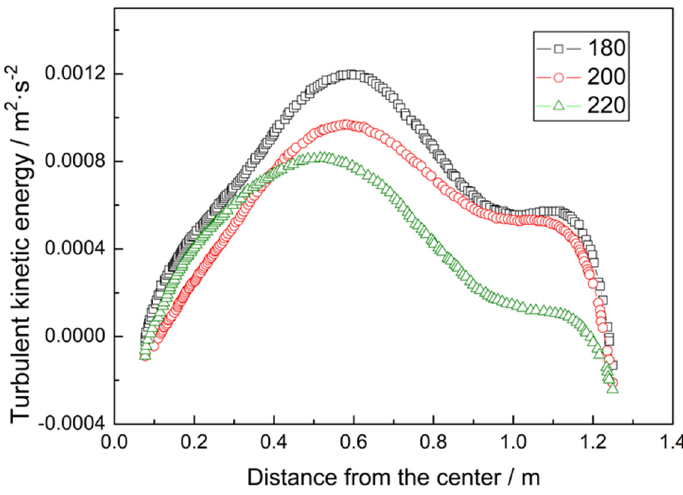
Figure 7. Turbulent kinetic energy at the free surface under different immersion depths.